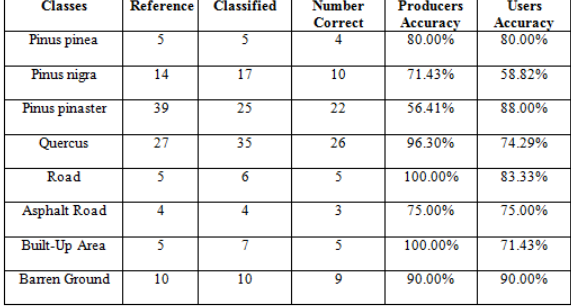
Table 1. Accuracy assessment results